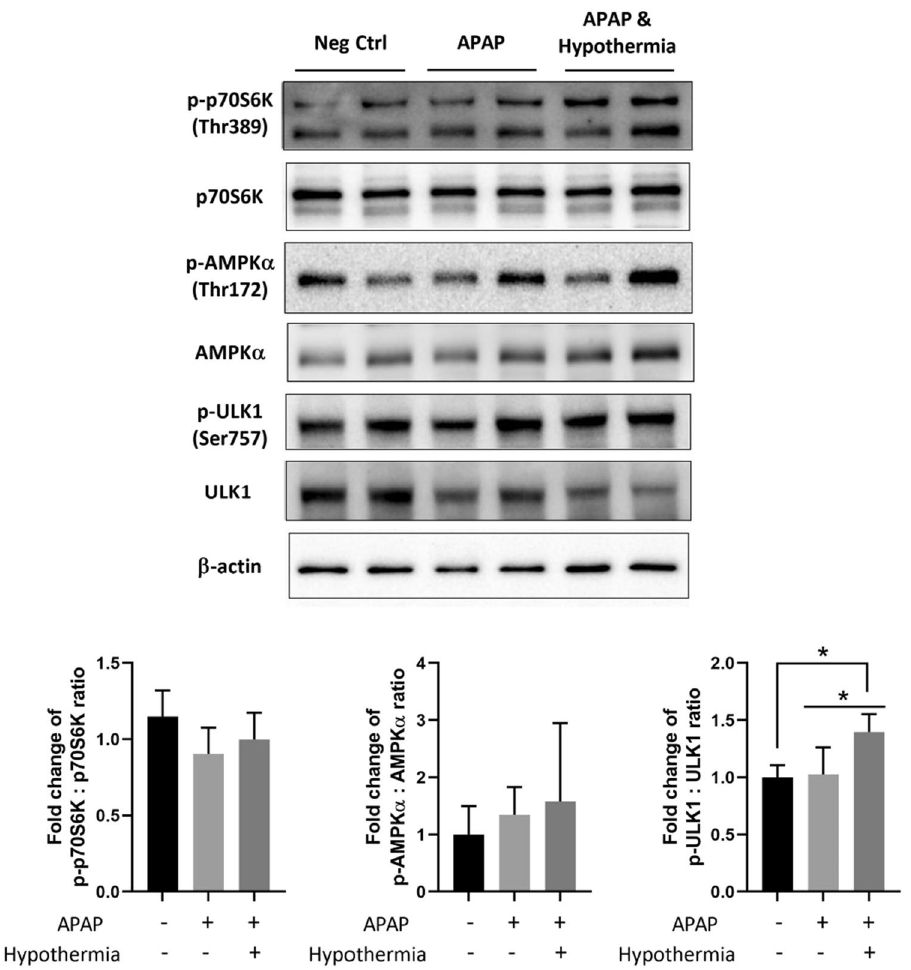
Figure 6. Effect of pulsed cooling on autophagy in mice. Western blotting was carried out to determine the protein expressions of autophagy-related markers including p-p70S6K, p70S6K, p-AMPKα, AMPKα, p-ULK1 and ULK1. β-actin was used as the housekeeping protein for all western blots; densitometric analysis was performed with ImageJ and normalized against the negative control i.e. mice without both APAP administration and pulsed cooling. Data are presented as mean ± SD (n ≥ 3) where one-way ANOVA was used to make comparison across different treatment groups and post-hoc tests were subsequently carried out with correction for multiple comparisons using Sidak’s method. * P <